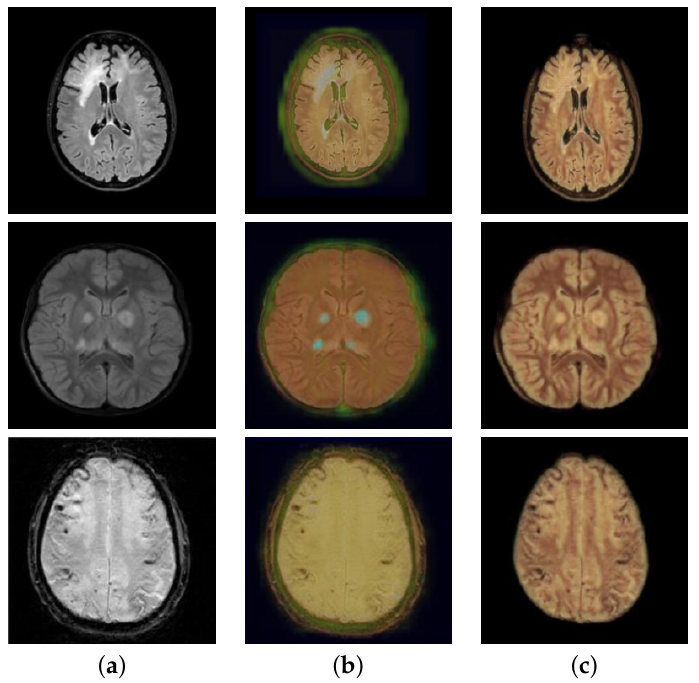
Figure 6. Comparison of the results with and without edge loss. ( a ) origin; ( b ) w/o edge loss; ( c ) w edge loss.